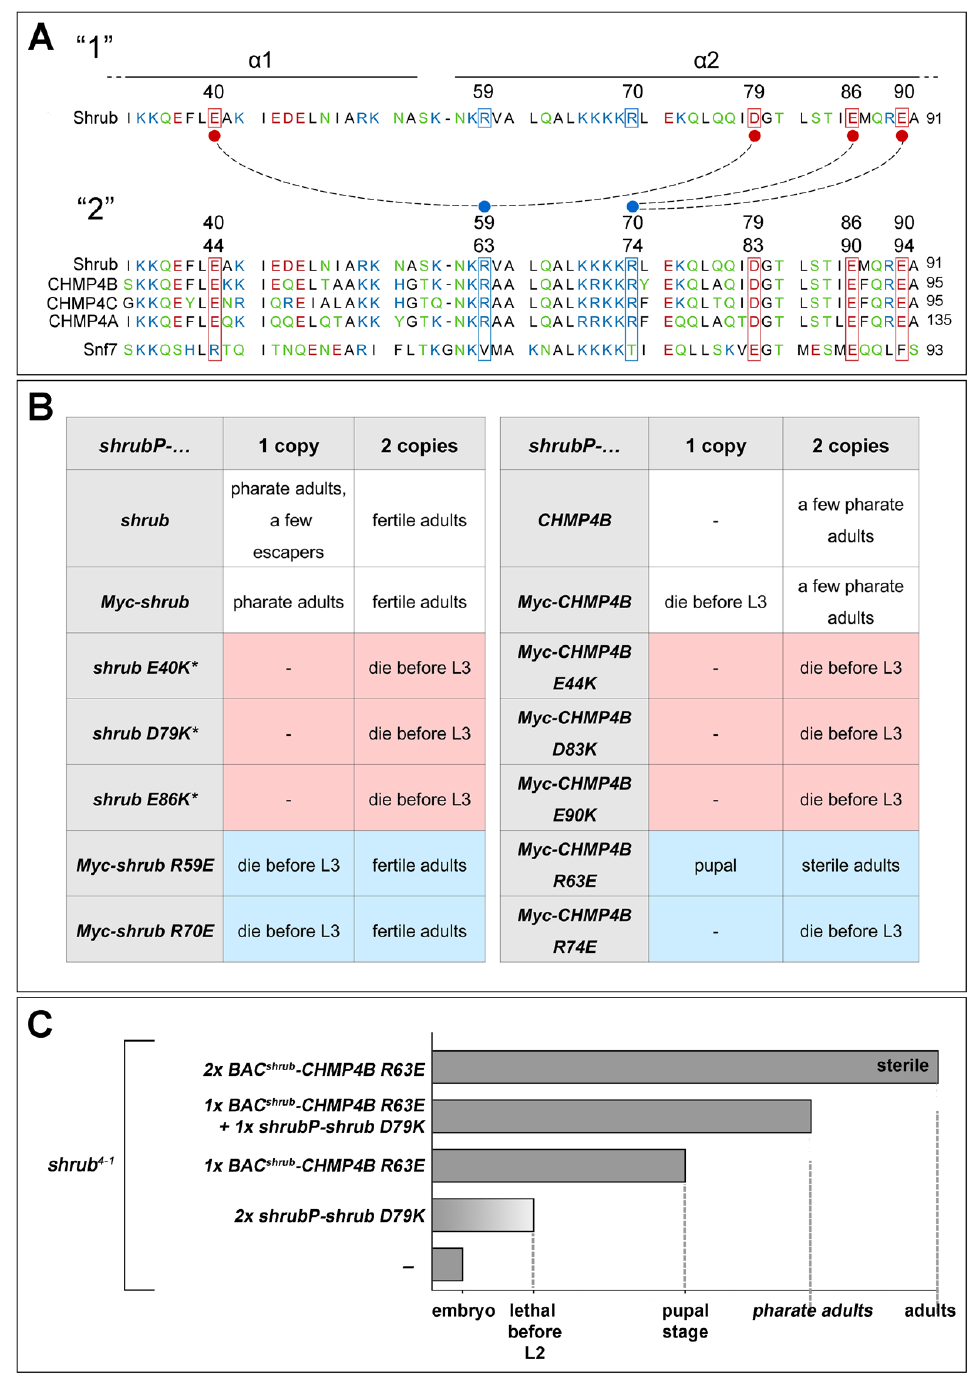
Figure 2. CHMP4B polymerisation relays on the same electrostatic interactions as Drosophila Shrub. ( A ) Primary sequence alignment of Shrub (AA 33–91), CHMP4s (AA 37–950), and yeast Snf7 (AA 34–93) (AA: polar: green; non ‐ polar: black; acidic: red; basic: blue). Residues involved in electrostatic interactions (dotted lines) between two Shrub monomers [7] are boxed and highlighted by the residue number (upper number: Shrub, lower number: CHMP4B). ( B ) Comparison of the results from shrub rescue experiments based on the shrub 4 − 1 lethality by various Shrub and human CHMP4B. ( C ) Complementation of Shrub and CHMP4B variants. A charge reversal on one position of Shrub (D79K) can be compensated by a complementary charge reversal at the position of the interacting AA in the complementary interaction surface of CHMP4B (R63E).